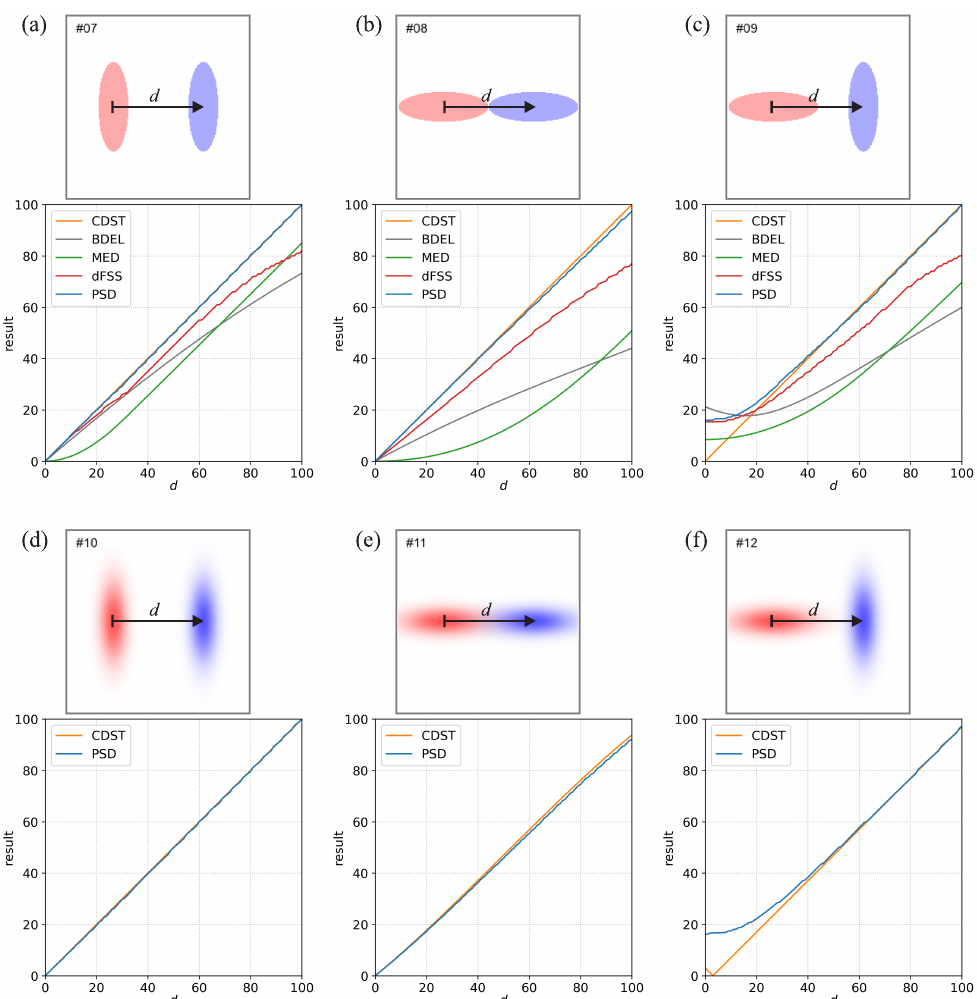
Figure 2. Same as Figure 1 but for the six comparisons that use a pair of either binary or Gaussian events of elliptical